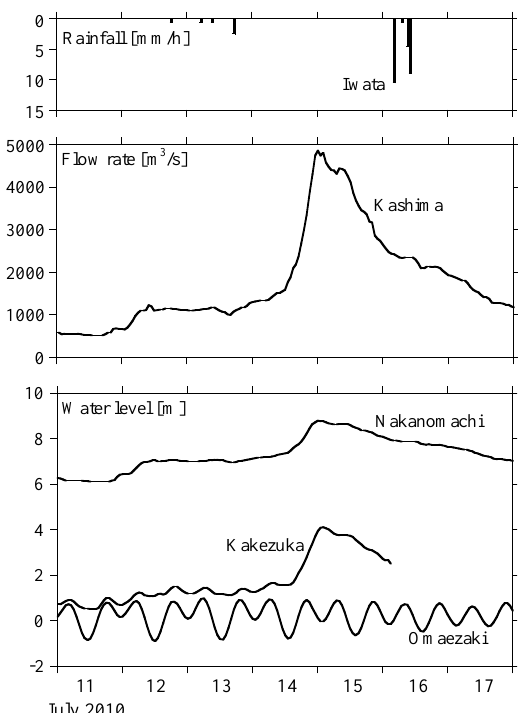
Figure 2. Variations of rainfall (upper panel), estimated flow rate (middle panel), and water levels in the river channel (Nakanomachi and Kakezuka) and sea (Omaezaki, bottom panel), observed during the flood.